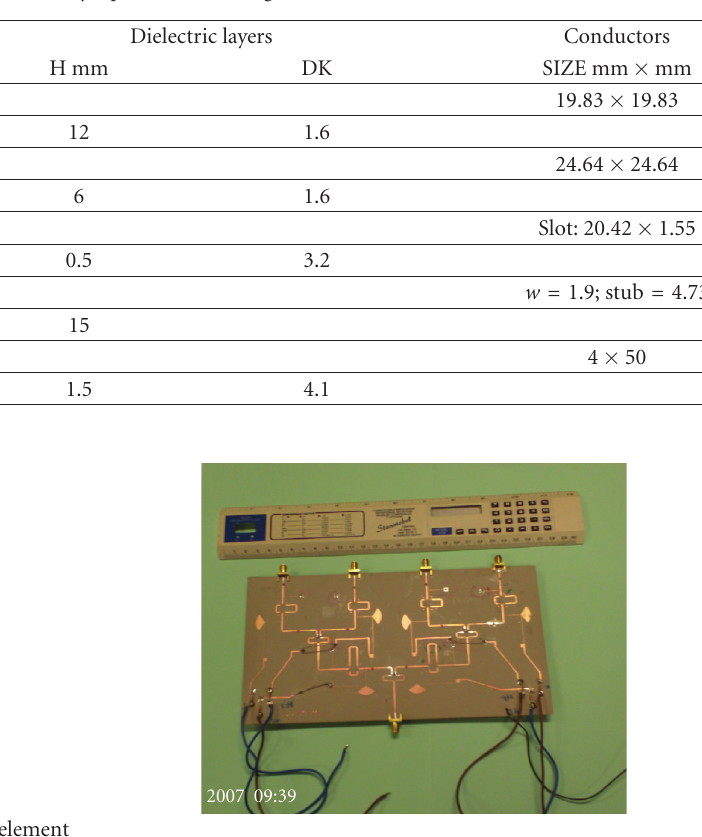
Figure 11: Prototype of feed network of the switchable